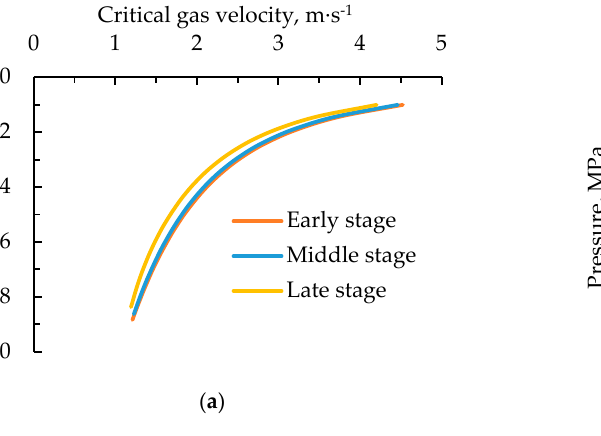
Figure 7. ( a ) The change in critical gas velocity in different periods; ( b ) the change in liquid–gas density in different periods.